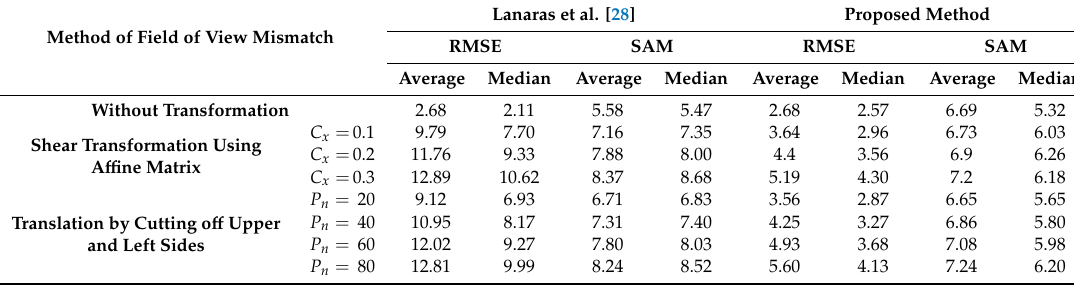
Table 3. Results for the Harvard